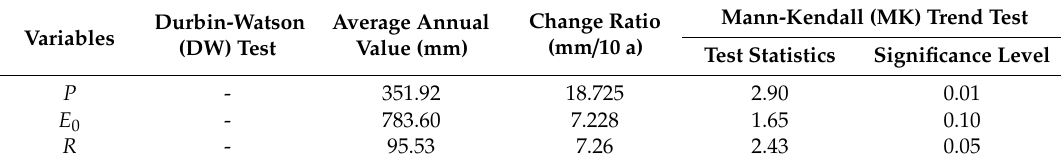
Table2. ResultsofchangecharacteristicsandMKtrendtestofprecipitation, potentialevapotranspiration and runo ff depth from 1966 to 2013 in the headwaters of the Yangtze River